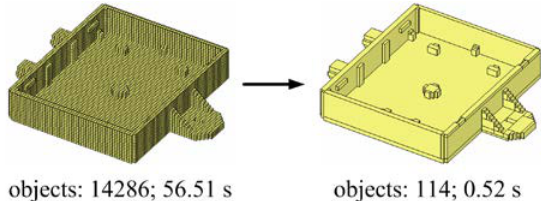
Fig. 6. Decomposition of a voxelized object of a complex geometric shape